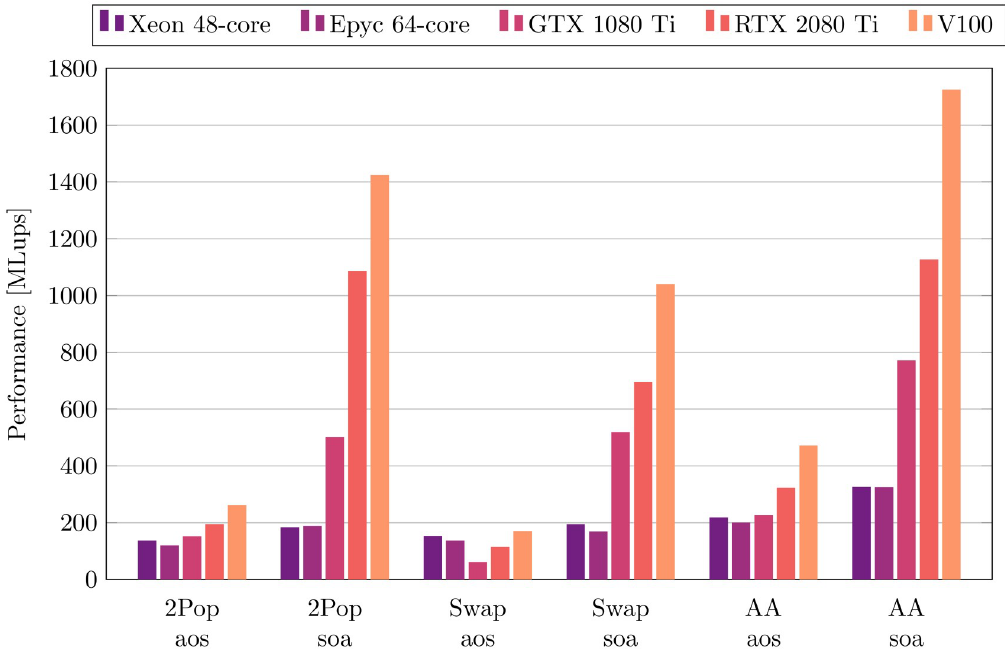
Fig 4. Performance of many-core CPU and GPU architectures. All simulations are executed with BGK-W2 collision model and N = 128. For best overall performance, the simulations on the 64-core Epyc CPU were executed without loop unrolling, while the 48-core Intel CPU and the two GPUs used loop